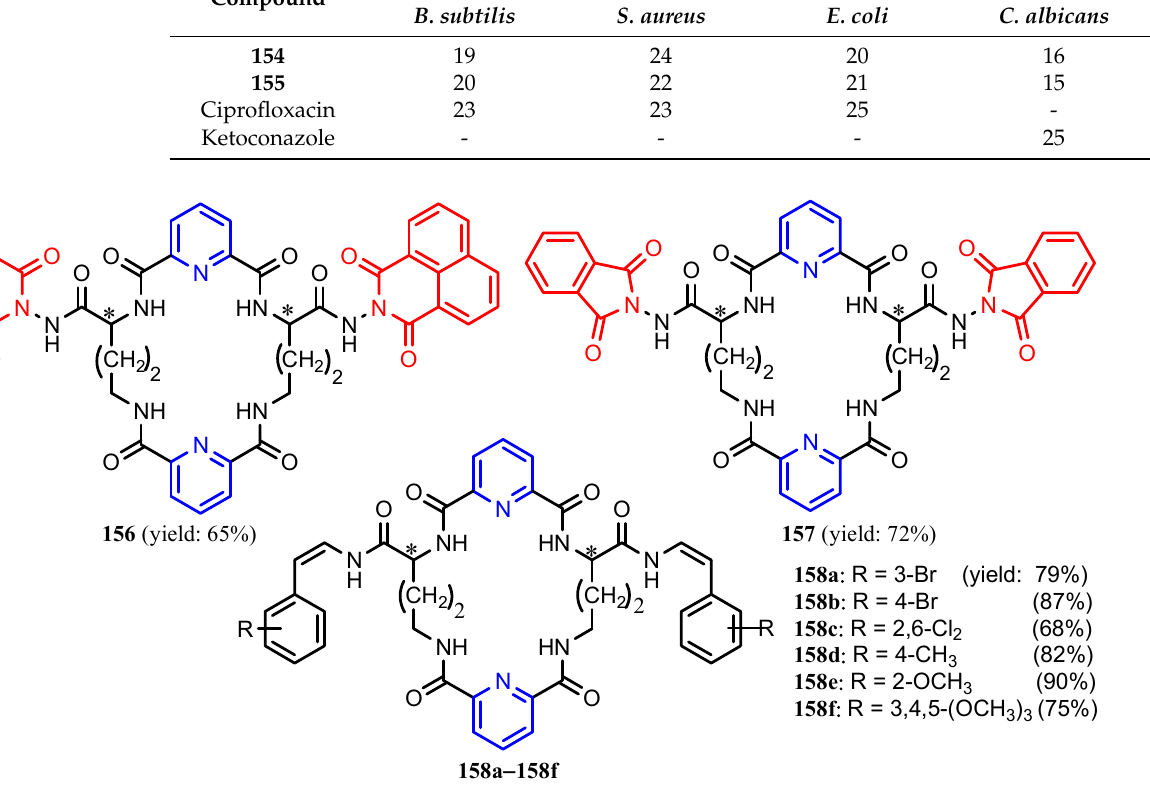
Figure 16. Structures of compounds 151 , 152 and 153a − 153f [67]. Table 9. Antimicrobial activities of the compounds 156 – 158